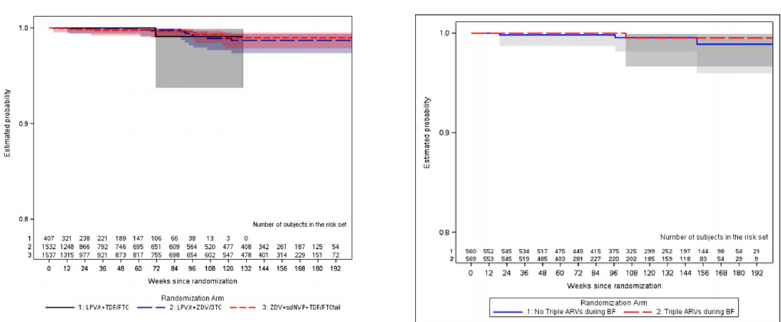
Fig 3. A. (AP-only): Time to first confirmed AIDS defining illness or death Fig 3B (PP-only) time to first confirmed HIV/ AIDS defining illness or death.